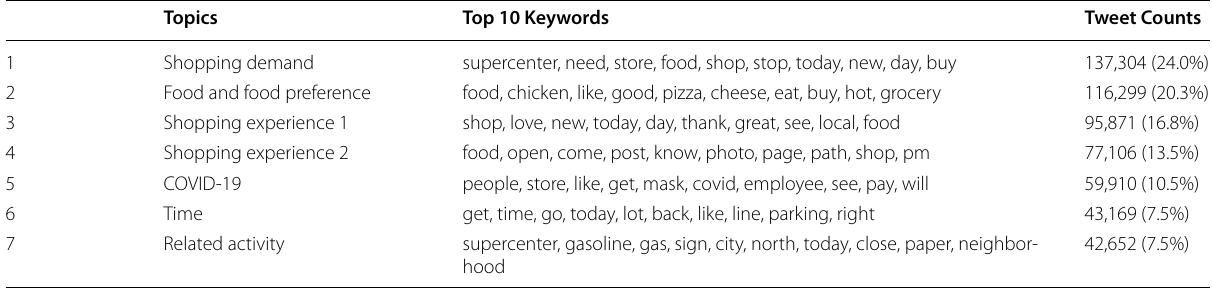
Table 1 The results of topics and their top-10 corresponding keywords from the 6-topic LDA model, along with the tweet counts under each